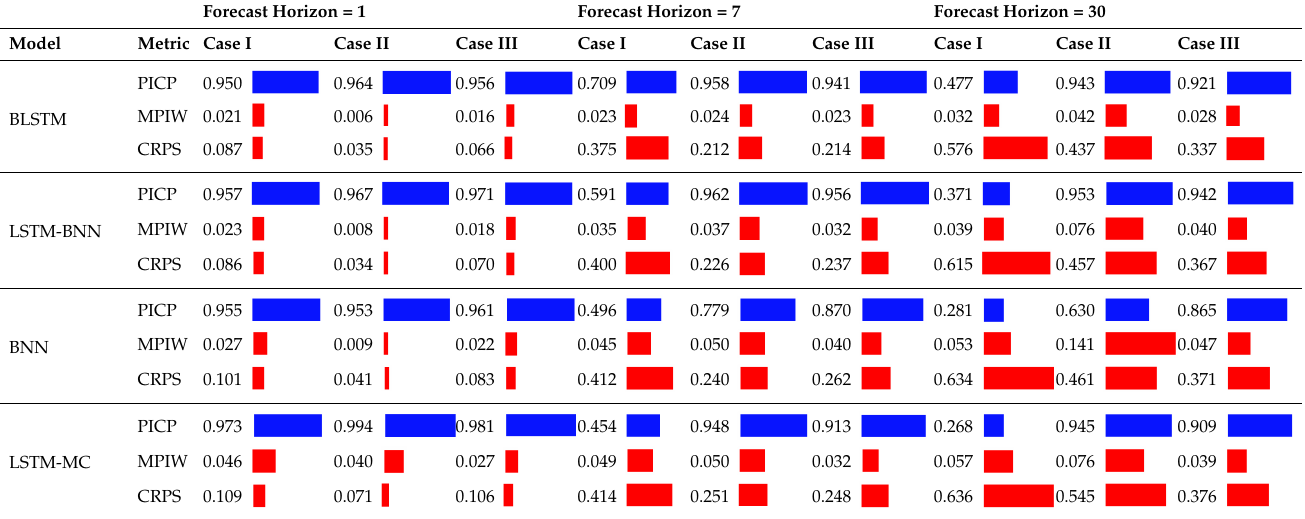
Table 4. Summary of prediction performance results for three case studies and three scenarios.